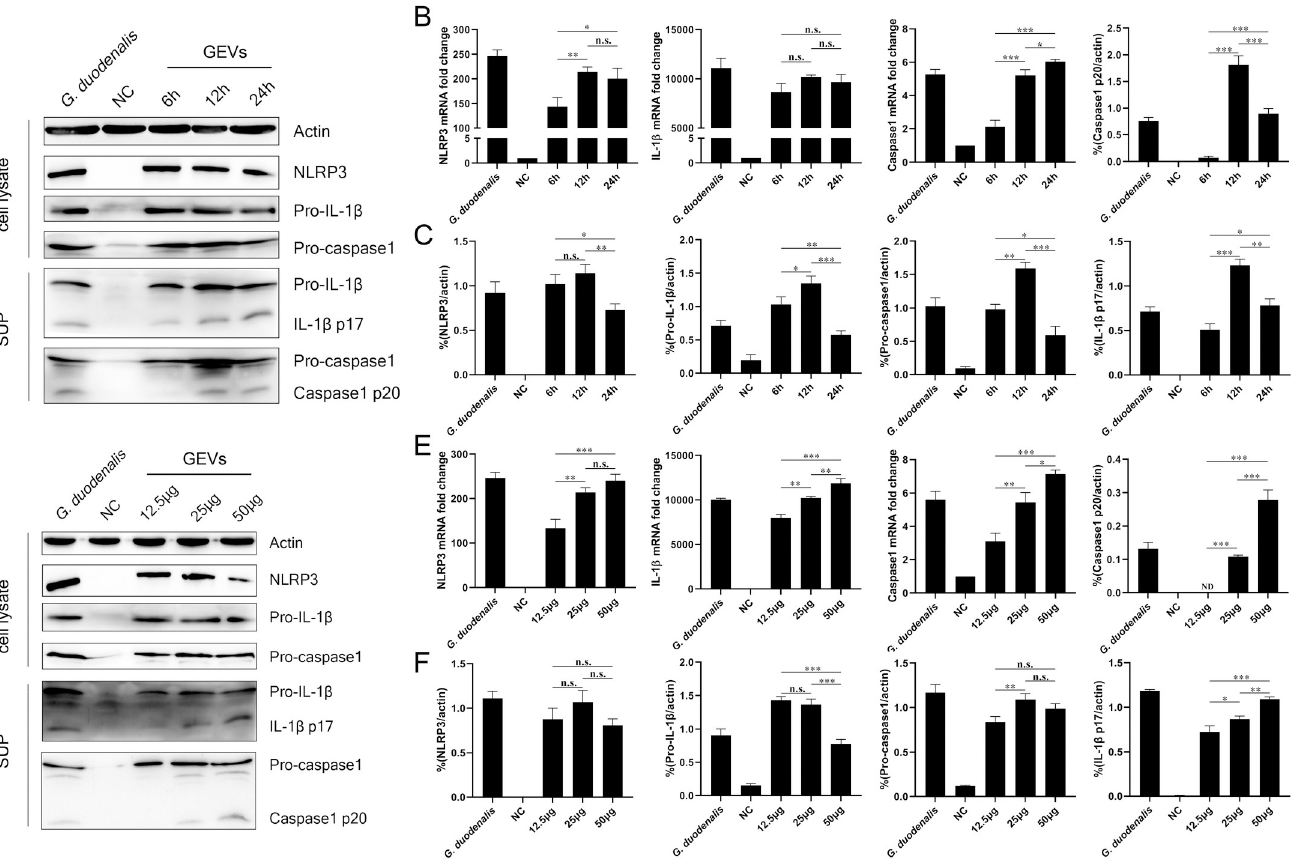
Fig 5. Activation of NLRP3 inflammasome in murine peritoneal macrophages. Cells were incubated with 25 μ g/mL of GEVs for 6 h, 12 h and 24 h or incubated for 12 h with 12.5, 25, 50 μ g/mL of GEVs. Protein expression of NLRP3 (110 KDa), Pro-IL-1 β (35 KDa), Pro-caspase1(45 KDa) in the cell lysate and IL-1 β p17 (17 KDa), Caspase1 p20 (20 KDa) in the SUP were detected using western blot (A and D). The mRNA fold changes of NLRP3, IL-1 β , Caspase1 were detected using qPCR (B and E). The protein expression levels were measured by calculating the ratio percentage of band density in target protein and housekeeping actin. (C and F). NC represented No GEVs-treated negative control group. G . duodenalis in A represented positive control with 1.5 × 10 6 parasites/mL for 24 h and in D represented positive control with 1.5 × 10 6 parasites/mL for 12 h. SUP represented cell culturing supernatants. The data are expressed as the mean ± SEM from three separate experiments, � p < 0.05, �� p < 0.01 or ��� p < 0.001 for different treated time groups or different treated amount groups.